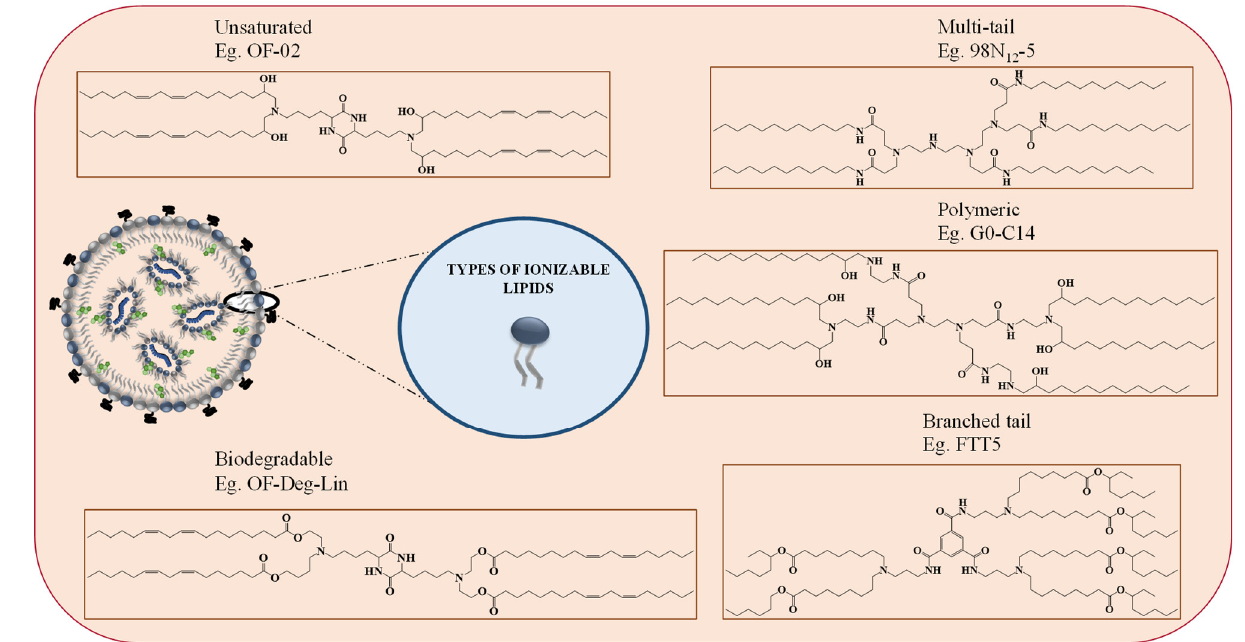
Figure 2. Shows the different types of ionizable lipids used in the composition of